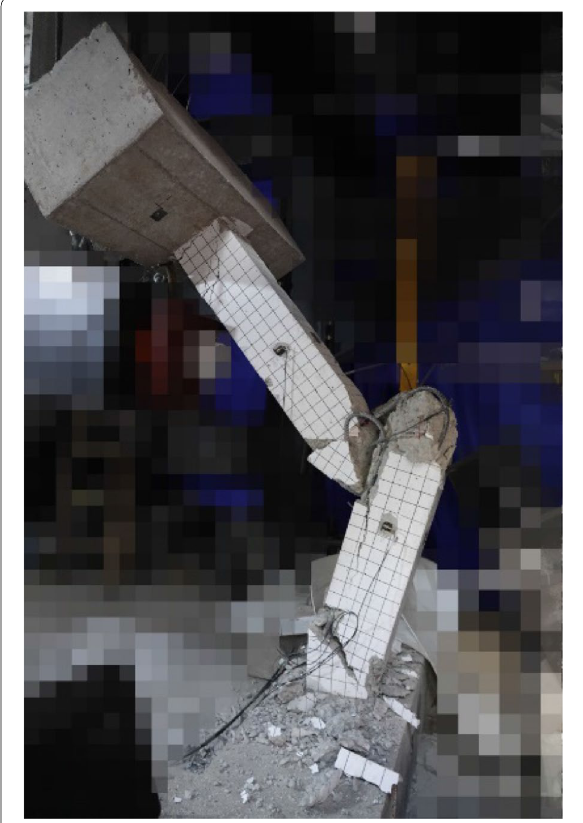
Fig. 9 The failure pattern of axially loaded column subjected to lateral impact. Image by courtesy of Sun (Hunan